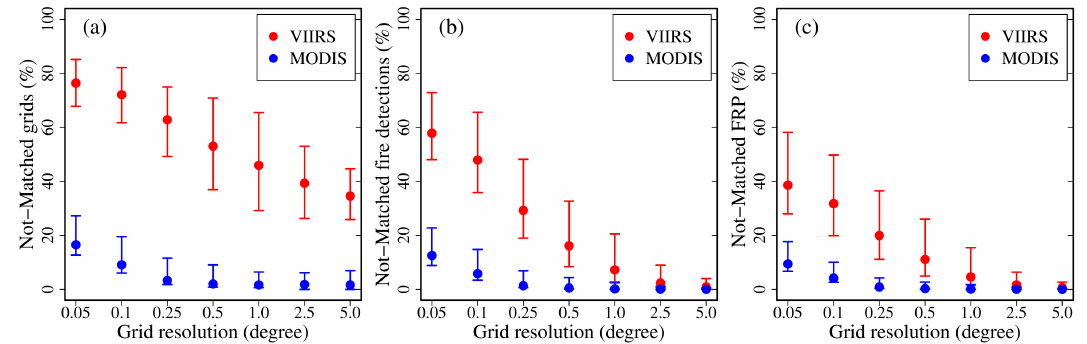
Figure 6. Percentages of the daily not-matched grids ( a ) and fire detections ( b ) and sum FRP ( c ) in these grids between Aqua MODIS (blue) and VIIRS I-band (red) at seven different resolutions across Africa. The solid cycles represent median values and the error bars indicate values at the 5th and 95th percentiles.